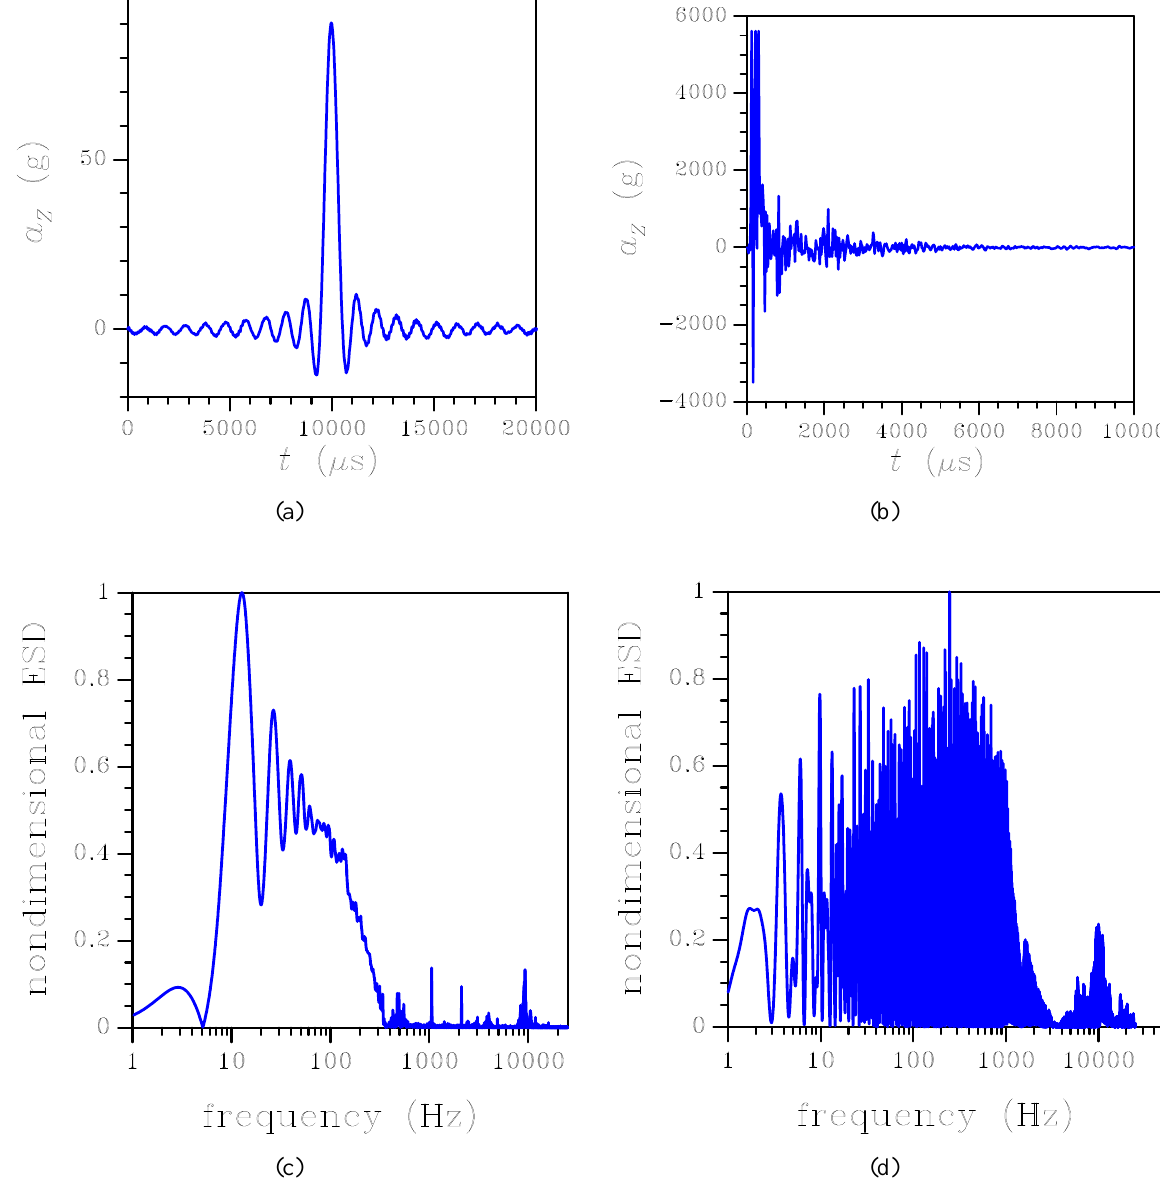
Figure 3. Shock tests. Top row: acceleration histories felt by the sensor during the ( a ) low- g and ( b ) high- g experiments. Bottom row ( c , d ): energy spectral density (ESD) obtained through a Fourier transform of the relevant input